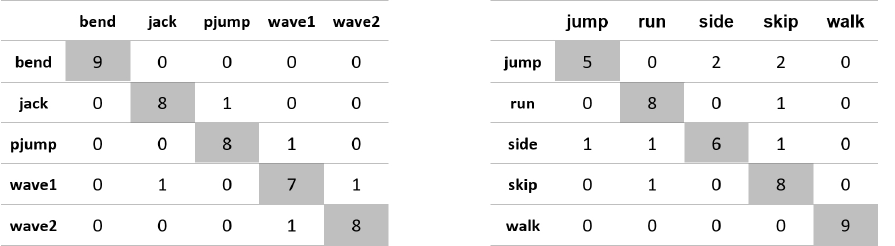
Figure A29. Confusion matrices for the experiment using the ‘upper-occlusion’ database, elongation and C1